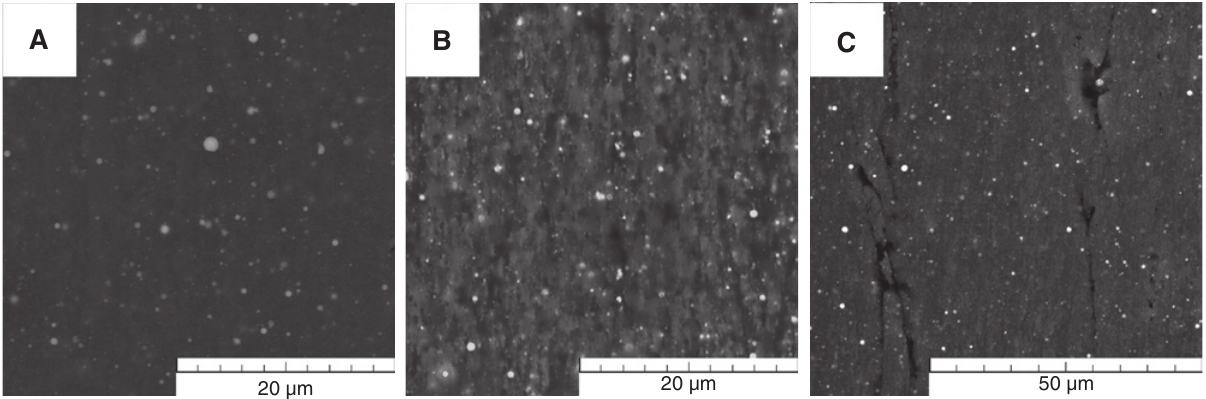
Figure 5: Mg-5HA prepared by mixing in planetary mill and extruded at (A) 300 ° C, (B) 400 ° C, and (C) 500 ° C.